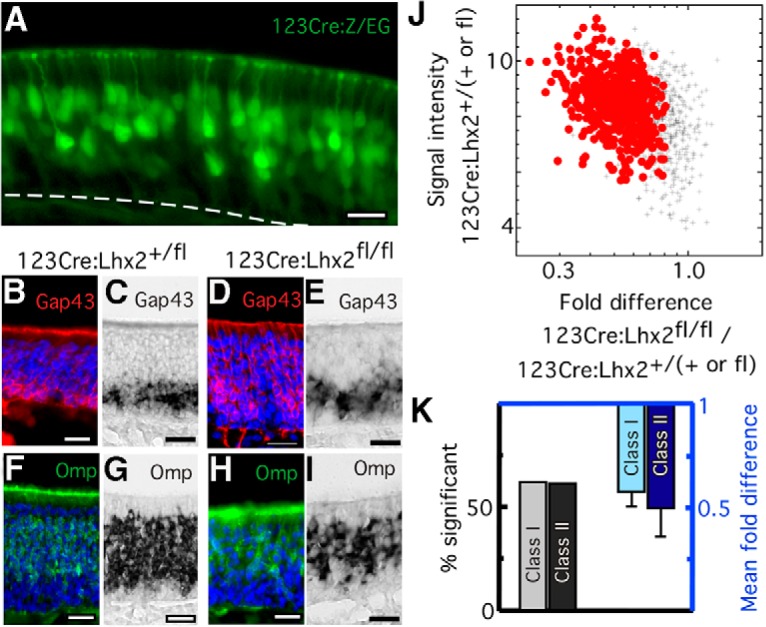
Conditional deletion of Lhx2 in immature OSNs decreases the abundance of most OR mRNAs. A, In 123Cre:Z/EG mice, recombination-dependent GFP expression marks OSNs in the immature and mature OSN layers of the olfactory epithelium. Dashed line, location of the basal lamina separating the olfactory epithelium and lamina propria. Scale bar, 20 µm. B–E, Gap43 immunoreactivity (B, D) and in situ hybridization for Gap43 mRNA (C, E) identify immature OSN cell bodies in 123Cre:Lhx2fl/fl mice (D, E) and littermate controls (B, C). F–I, Omp immunoreactivity (F, H) and in situ hybridization for Omp mRNA (G, I) identify mature OSN cell bodies in 123Cre:Lhx2fl/fl mice (H, I) and littermate controls (F, G). Scale bars, 20 µm. J, In 123Cre:Lhx2fl/fl mice, the abundance of 676 OR mRNAs decreases (p < 0.01; n = 4; FDR <1%). •, Significant decrease; +, no difference from littermate controls. K, The percentage of class I ORs affected by Lhx2 deletion in immature OSNs is very similar to the percentage of Class II ORs affected, and the magnitude of the decreases are similar for both classes of ORs. Error bars represent SDs.